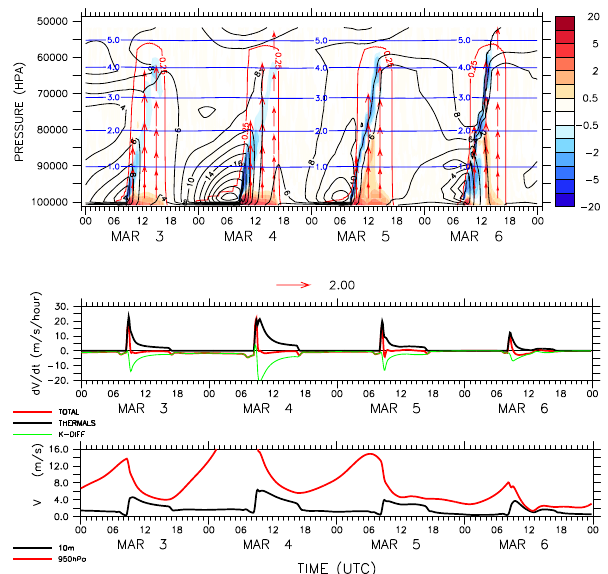
Figure 9. The diurnal cycle of the boundary layer at Banizoumbou over 4 consecutive days in early March 2006 is shown in the upper panel: the vertical distribution of the module of the horizontal wind (black contours, ms − 1 ) and the wind module tendency due to ver- tical transport by the thermal plume model, according to Eq. (7) (colored shades with absolute iso values 0.5, 1, 2, 3, 5, 10 and 20ms − 1 h − 1 ). The red contour delimits the depth of the bound- ary layer and corresponds to the 0.25 value of the bulk Richardson number (Eq. 8). The red arrows correspond to the thermal plume velocity in ms − 1 (under-sampled with respect to the space–time discretization of the simulation). The vertical axis, in pressure (Pa), and the altitude (in kilometers, blue contours) are also shown. In the middle panel, we show for the first model layer (located at about 30m above surface), the decomposition of the total wind module tendency (TOTAL, red, ms − 1 h − 1 ) as the sum of the thermal plume contribution (THERMAS, black) and turbulent diffusion (K-DIFF, green). The lower panel shows the wind speed at 10m (black) and 950hPa (red), close to the altitude where the nocturnal jet reaches its